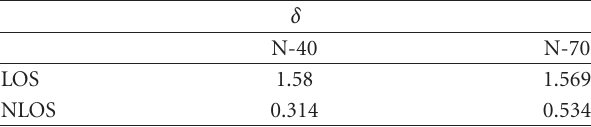
Table 1: Frequency decaying factor.